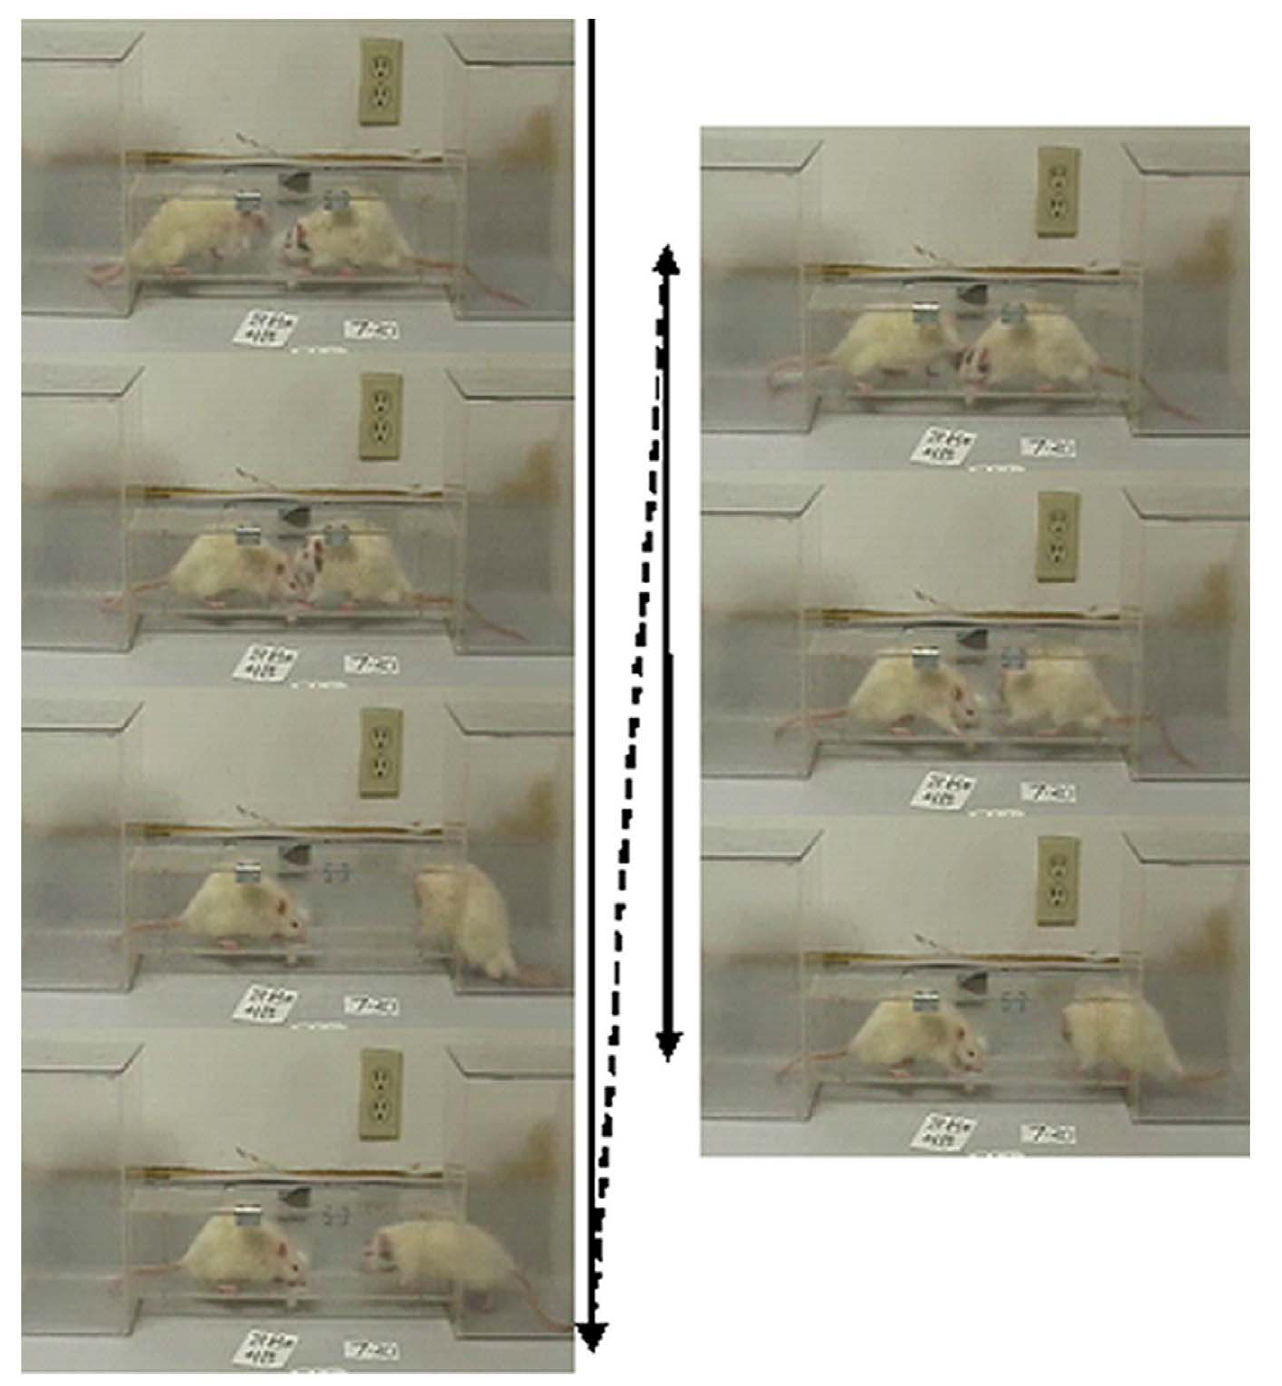
Figure 1. A sequence of frames from a late competition. The rat on the left (dominant) supplants the rat on the right (subordinate) at the milk cup. The latter retreats then returns; he is pushed back by the dominant rat and, unable to regain control of the milk cup, retreats